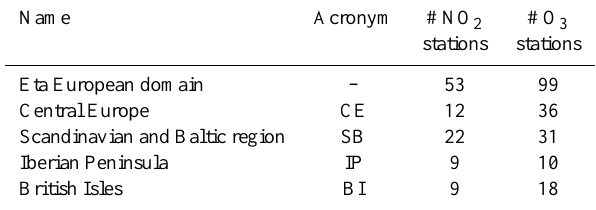
Table 2. The number of monitoring stations satisfying the inclusion criteria in each of the regions considered (Fig.